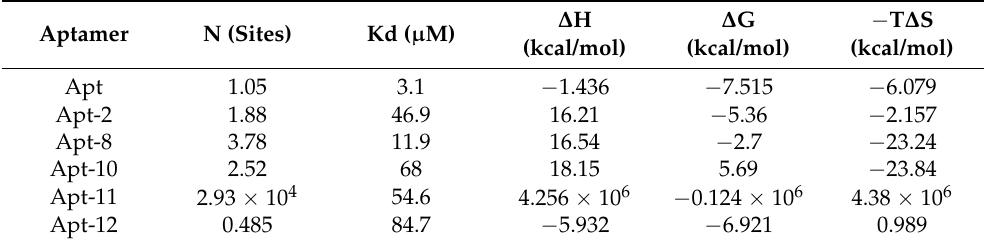
Table 2. ITC results for original aptamer and truncated aptamer.